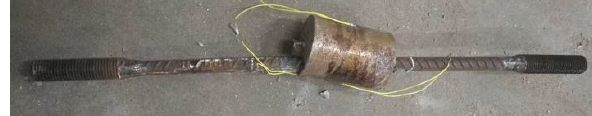
Figure 12. Steel bar pull out.